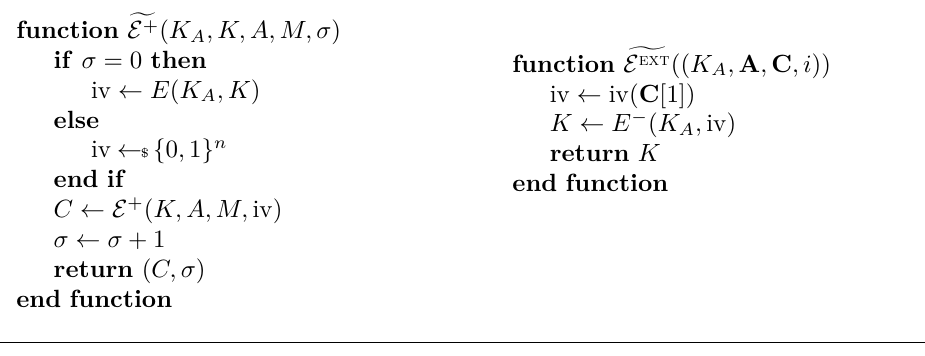
Algorithm 2.2 Pseudocode of the subversion attack from [BJK15]. Here E denotes encryption scheme that uses n -bit IVs, E is a length-preserving deterministic encryption scheme, and F a PRF with range { 0 , 1 } × { 1 , . . . , k } , where k denotes the key size of E